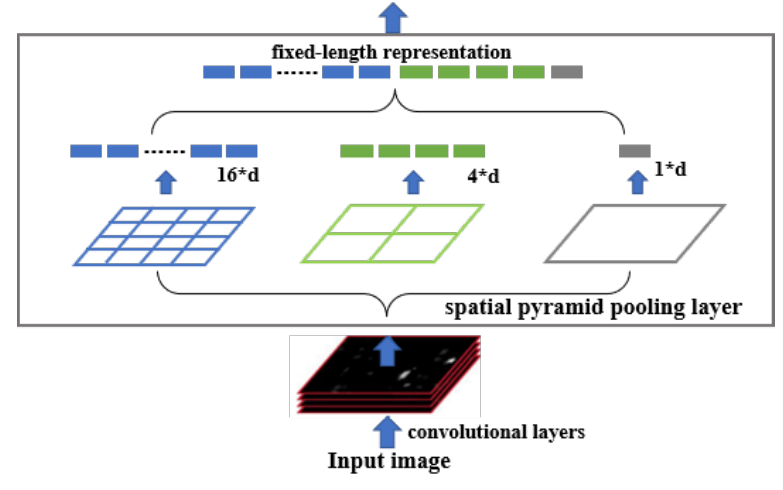
Figure 8. Illustration of the SPP module structure, redrawn according to [41]. Extraction of features using multiple pooling layers at different scales and fusion into a 21-dimensional vector input for the fully connected layer.